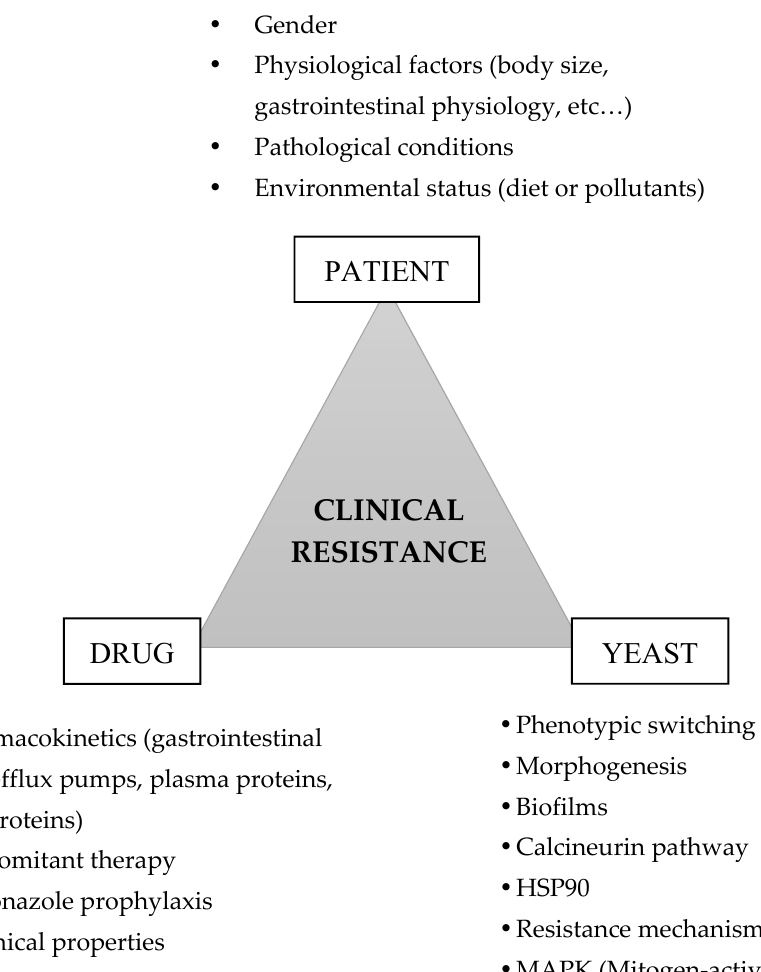
Figure 1. Risk factors that contribute to clinical resistance. Information was collected from the following references: [5,13,47,54,76,95,100,103,122,126,141–146].